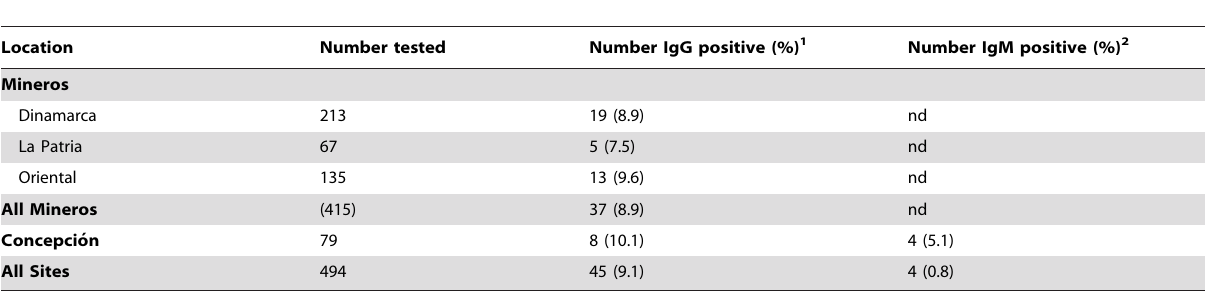
Table 1. Hantavirus antibody prevalence by ELISA in Mineros and Concepcio´n, Bolivia, 2002.